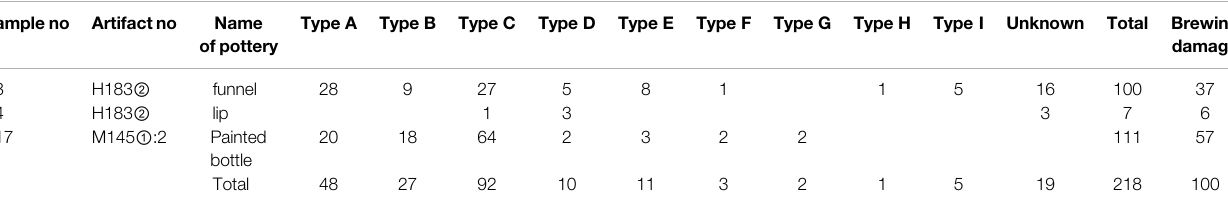
TABLE 1 | Starches from the Qingtai site. Sample no Artifactno